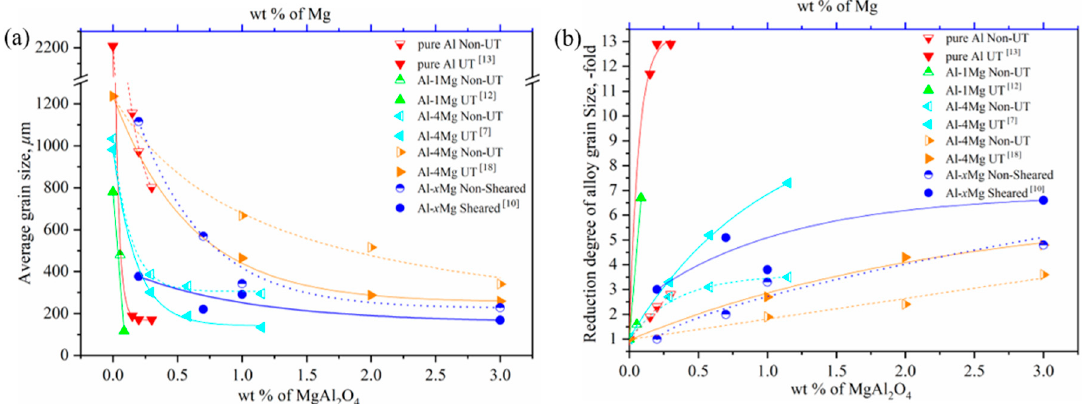
Figure 1. ( a ) The average grain size with respect to the mass percent of MgAl 2 O 4 or Mg with UT or an intensive melt shearing process; ( b ) the reduction degree of the grain size relative to the mass percent of MgAl 2 O 4 or Mg with UT or an intensive melt shearing process, with data from References